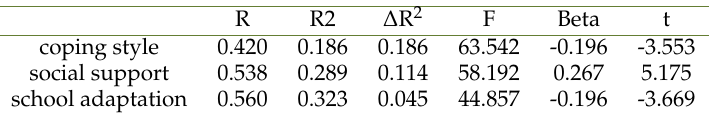
Table 4. Analysis of the Crawler Algorithm for the Relationship between Coping Style,Social Support and School Adaptation in Higher Vocational